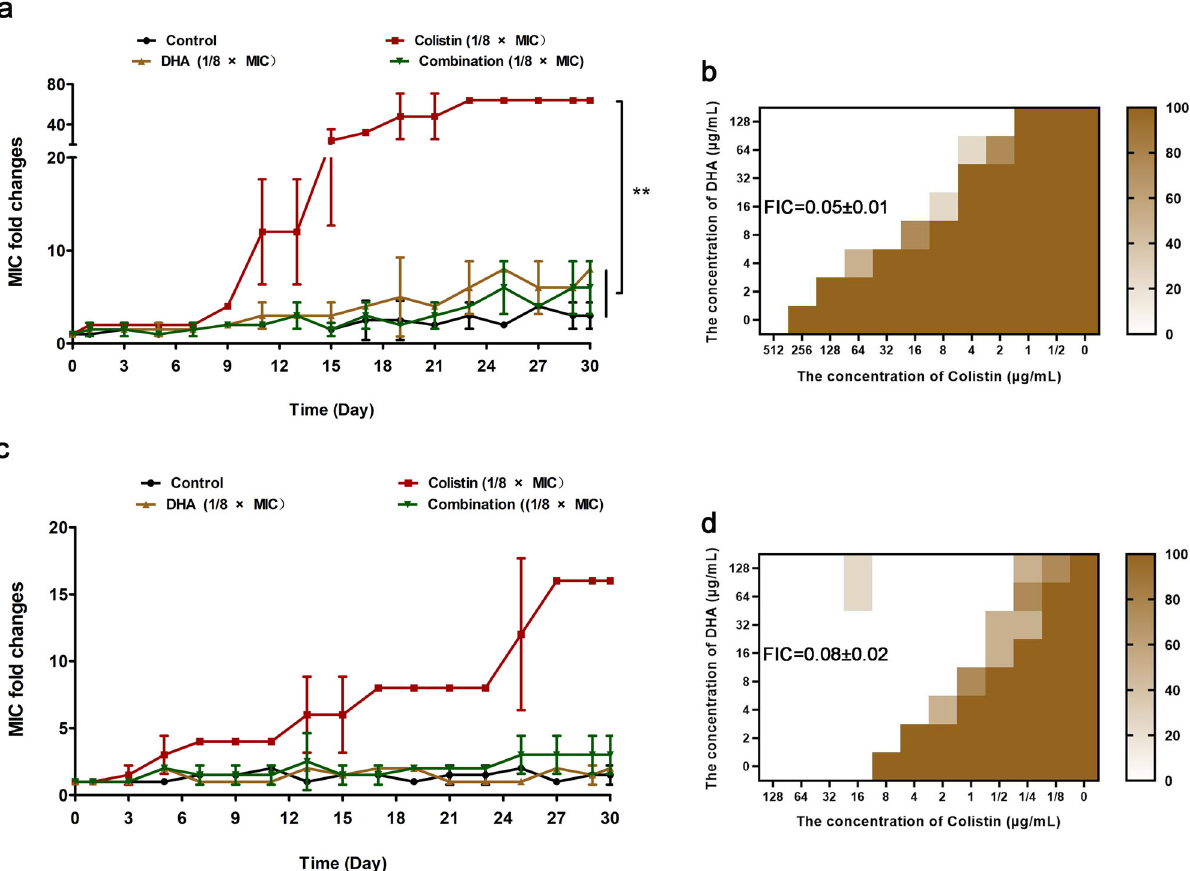
Fig. 4 DHA (1/8 × MIC) does not induce the resistance of bacteria to colistin. a , c MIC fold changes of 1/8 × MIC DHA, 1/8 × MIC colistin or 1/8 × MIC combination (the concentration of DHA was 16 µ g/mL) of E. coli W3110 (pUC19- mcr-1 ) ( a ) and E. coli W3110 (pUC19) ( c ). b , d The checkerboard MIC of E. coli W3110 (pUC19- mcr-1 ) ( b ) and E. coli W3110 (pUC19) ( d ) following 1/8 × MIC colistin induction was determined after day 30. All checkerboard MICs were determined in quadruplicate, and used the color shade to indicate the probability of bacterial growth in the well. The more bacterial growth visible to the naked eye, the darker the color. The concentration of DHA was 16 µ g/mL calculated for FIC. ** P <